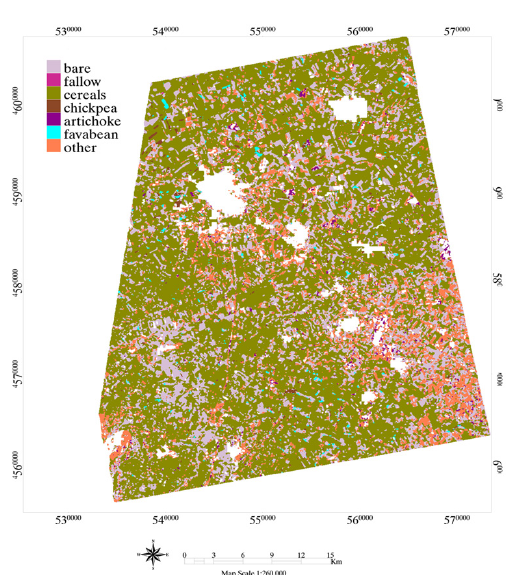
Figure 1. Winter crop map over the Apulian Tavoliere site (Italy) derived from multi-temporal Sentinel-1 images in 2015.